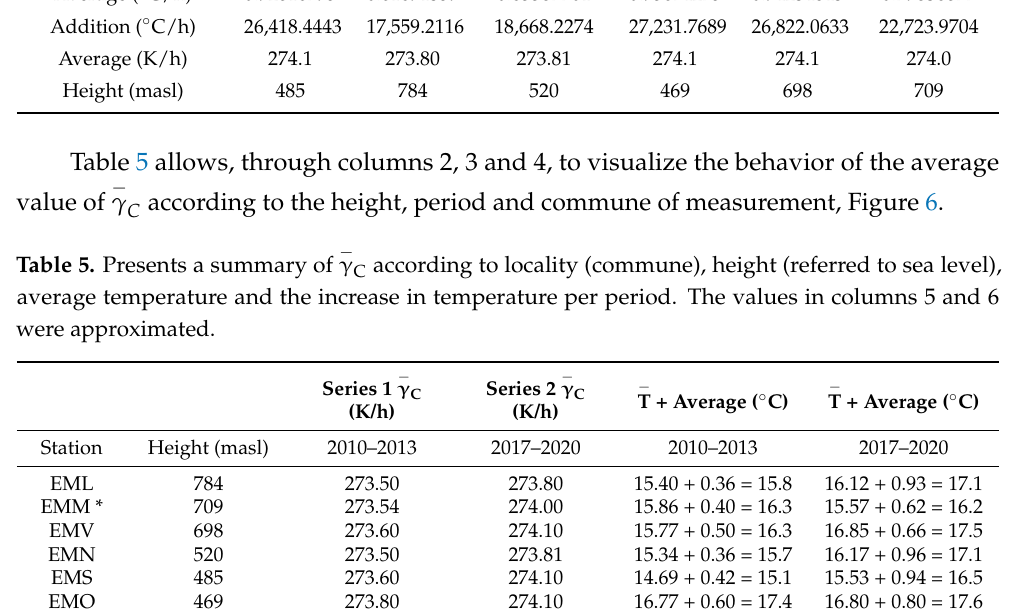
construction of high-rise buildings). Figure 6 represents